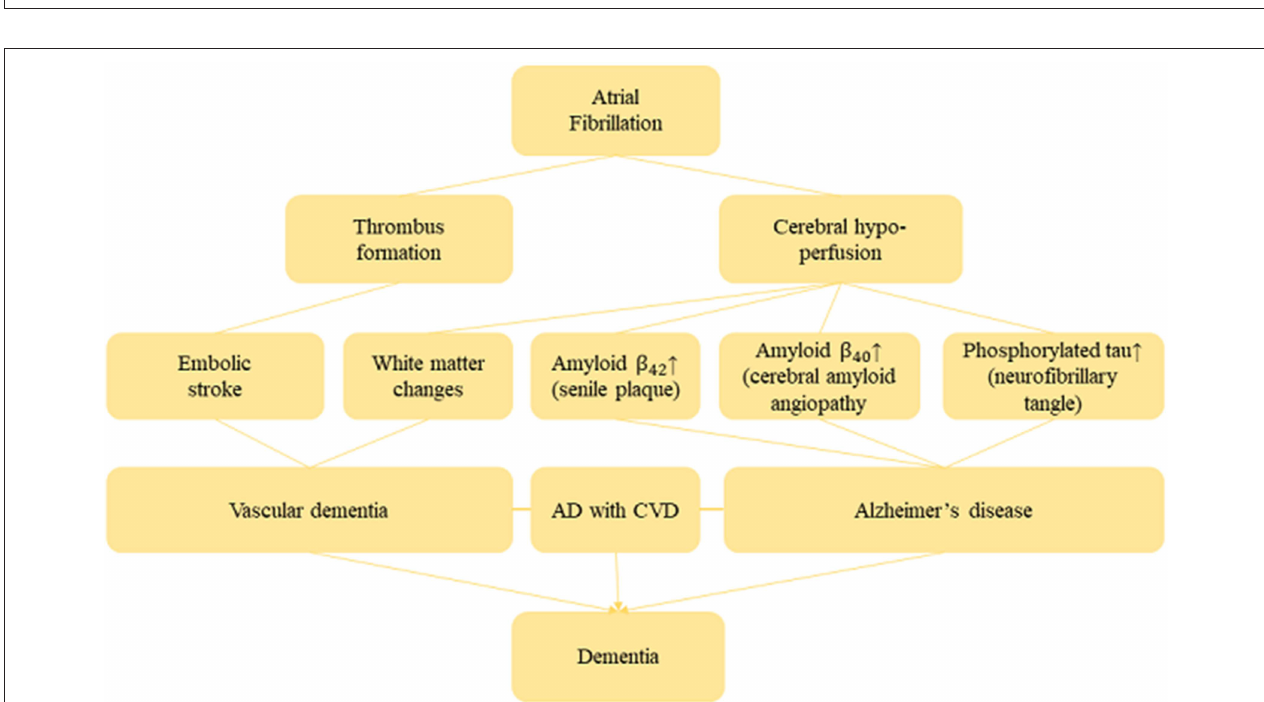
FIGURE 9 | Biological mechanism between AF and dementia.